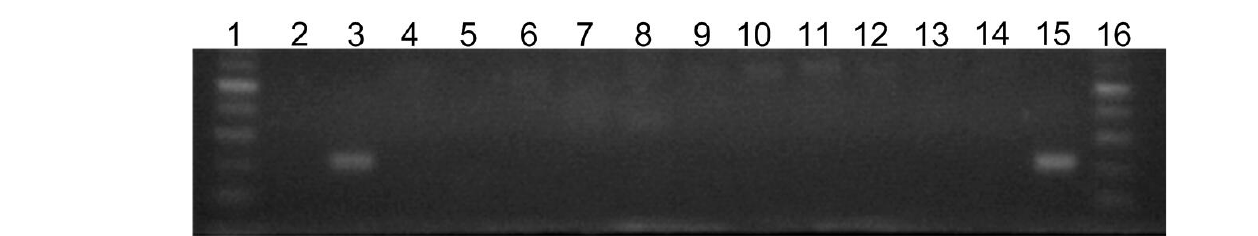
Figure 3. Agarose gel electrophoresis of PCR products for presence of silE gene (220 bp) in P. aeru- ginosa strains. Lanes: 1 and 16 molecular size markers (1000 bp, Fermentas), 2—negative control,